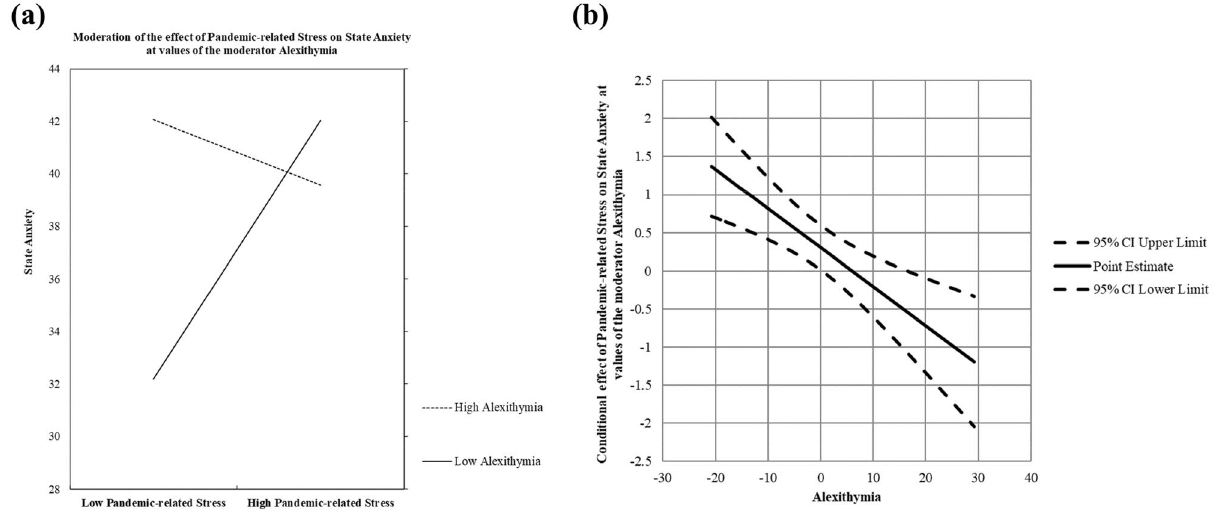
Figure 2. The conditional effect of pandemic-related stress on state anxiety at different levels of